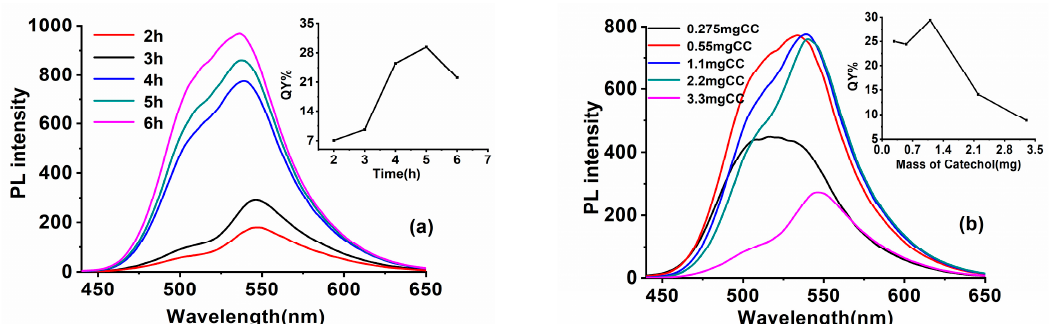
Figure 2. PL spectra of SiQDs synthesized with CC and Na-Citrate ( a ) with different addition mass of Na-citrate ( b ) with different addition masses of CC. The insets show the corresponding QYs.